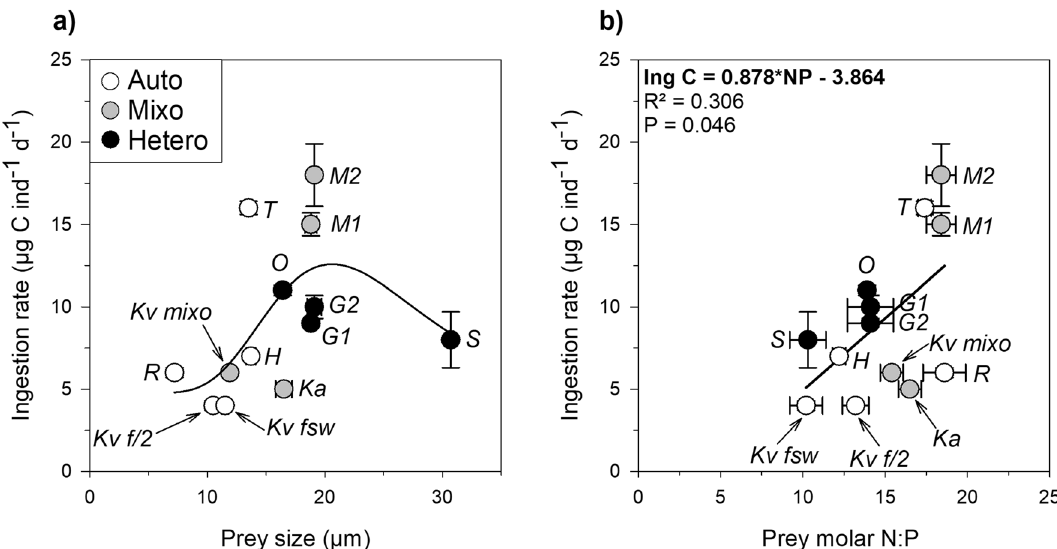
Figure 2. Ingestion rate of adult female P. grani as a function of ( a ) prey size and ( b ) prey N:P ratio. Non-linear fit with peak Sigma-Plot function in ( a ) and simple linear regression fit and corresponding equation in ( b ) are provided. Abbreviations are described in Table 3. Error bars are ± 1